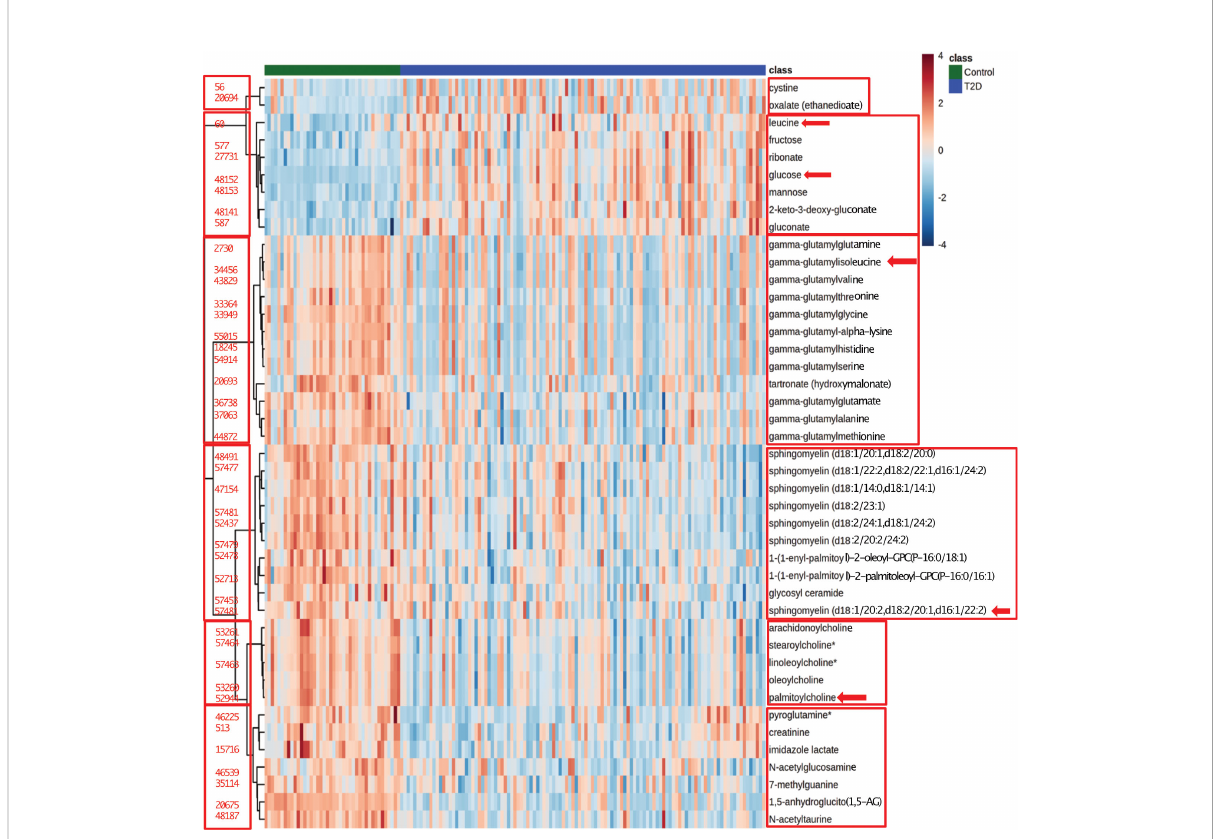
FIGURE 2 Heatmap of differential levels of 43 serum metabolites. 43 metabolites that were signi fi cantly different between T2D adolescents (blue color class) and control adolescents (green color class). Red color indicates the increased and the blue indicates reduced levels. The red boxes show the six major clusters formed. On the left of cluster is shown the compound identi fi cation for the respective metabolite. The red arrows show the fi ve metabolites that were used for data